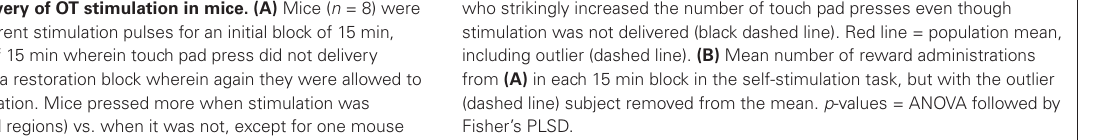
FIGURE 2 | Self-delivery of OT stimulation in mice. (A) Mice ( n = 8) were allowed to deliver current stimulation pulses for an initial block of 15 min, followed by a blank of 15 min wherein touch pad press did not delivery stimulation, and later a restoration block wherein again they were allowed to deliver current stimulation. Mice pressed more when stimulation was available (gray shaded regions) vs. when it was not, except for one mouse